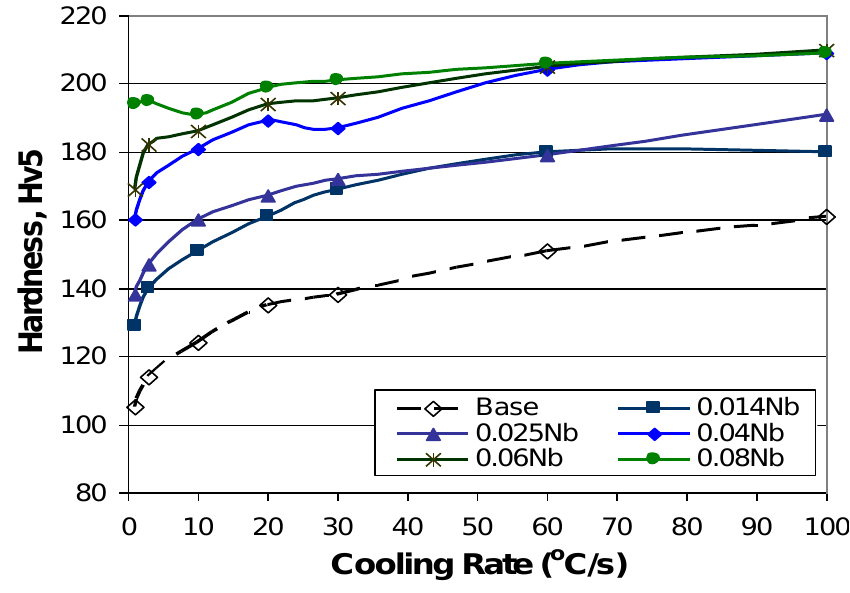
Figure 13. Vickers hardness, Hv5, as a function of increasing cooling rate and increasing Nb addition.